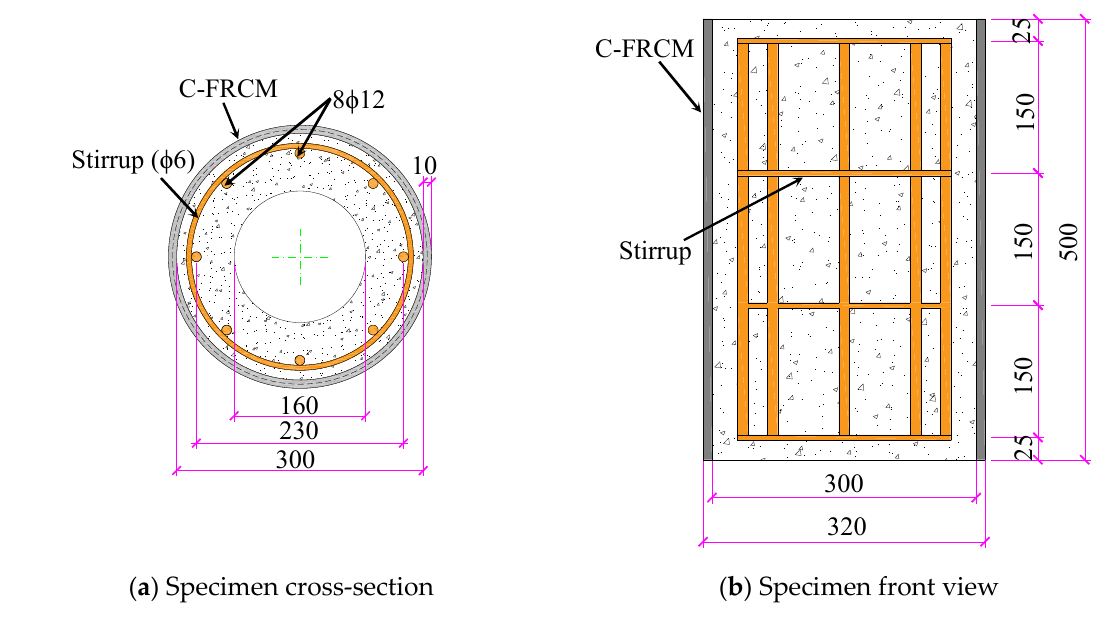
Figure 3. Details of specimens under the protection of ICCP-SS (unit: mm).